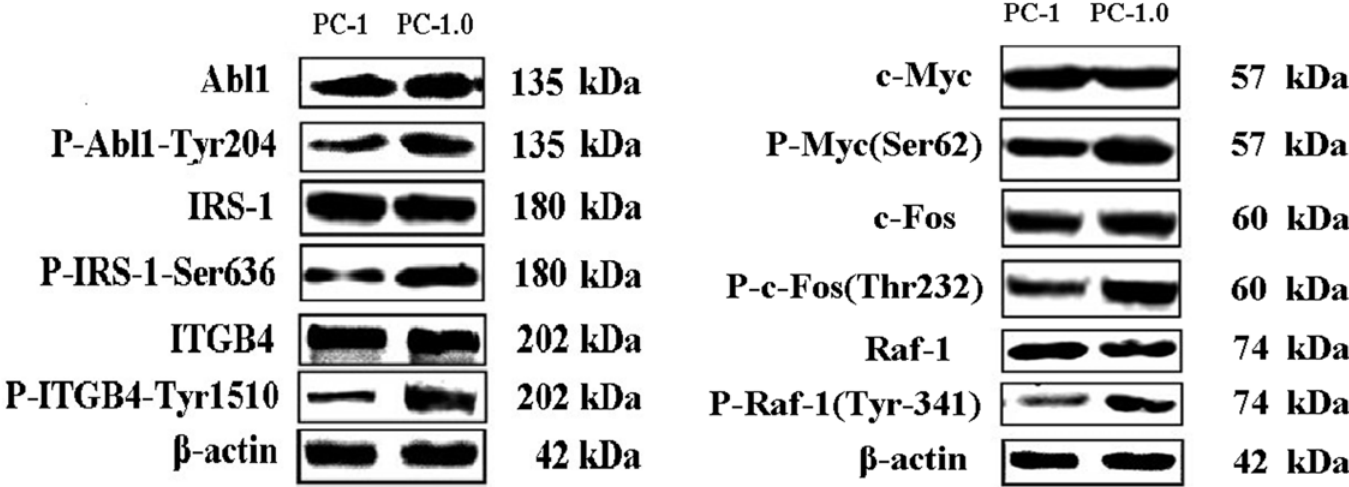
Fig 1. Western blots showing differential phosphorylation of proteins in highly (PC-1.0) and weakly (PC-1) invasive and metastatic pancreatic cancer cells. As shown, the total expression of each protein was equal in both cell lines, while at the phosphorylation level, the expression of six proteins was stronger in PC-1.0 cells than PC-1 cells. Molecular markers are indicated.